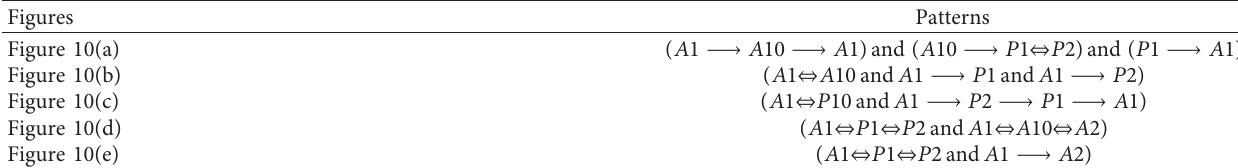
Table 5: The list of flow patterns inferred from all tourists. Figures